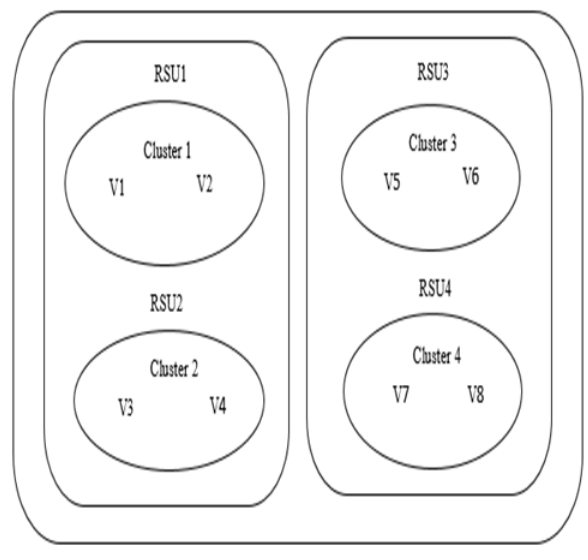
Figure 4. RSU cluster formation for dissemination of